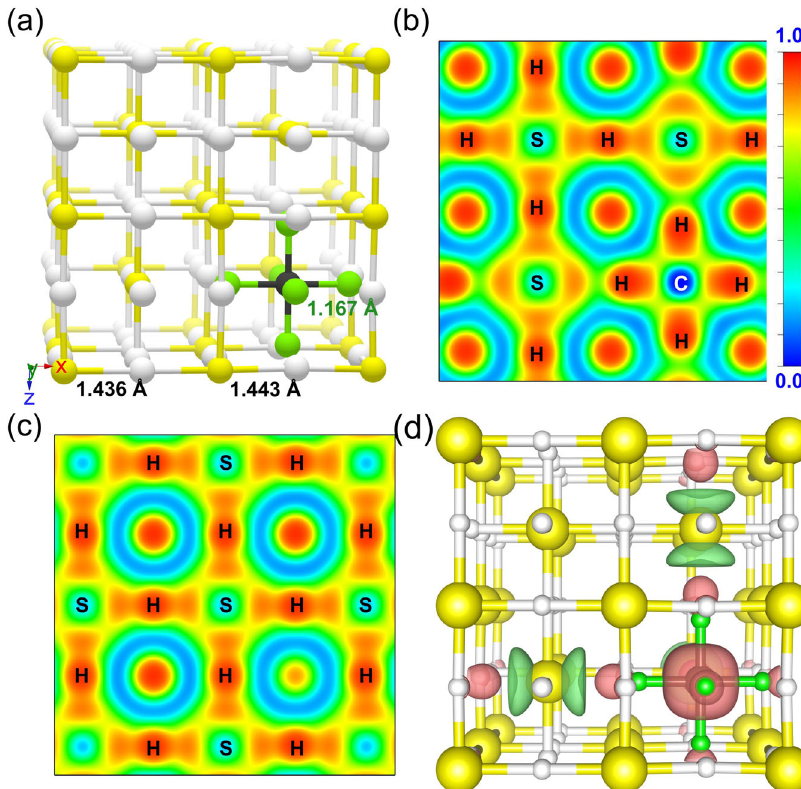
Fig. 1 Geometry and electronic structure of O h -CS 15 H 48 . a Optimized geometry and b , c electron localization function (ELF) contour plot of C 0.0625 S 0.9375 H 3 ( O h -CS 15 H 48 , space group Pm 3 m ), where the carbon atom is octahedrally coordinated by hydrogen atoms at 270 GPa. The plane of the contour passes through b CH 6 and c H 3 S, and the range of the isovalues is from 0.0 (blue/cold) to 1.0 (red/warm). The atoms through which the plane passes are labelled. d The following electron density difference: ρ (CH 6 ) + ρ (S 15 H 42 ) − ρ (CS 15 H 48 ) where red denotes a loss of charge and green a gain of charge (isovalue = 0.005). Sulfur/carbon/hydrogen atoms are yellow/black/white and select geometric parameters are provided. Hydrogen bonded to carbon is